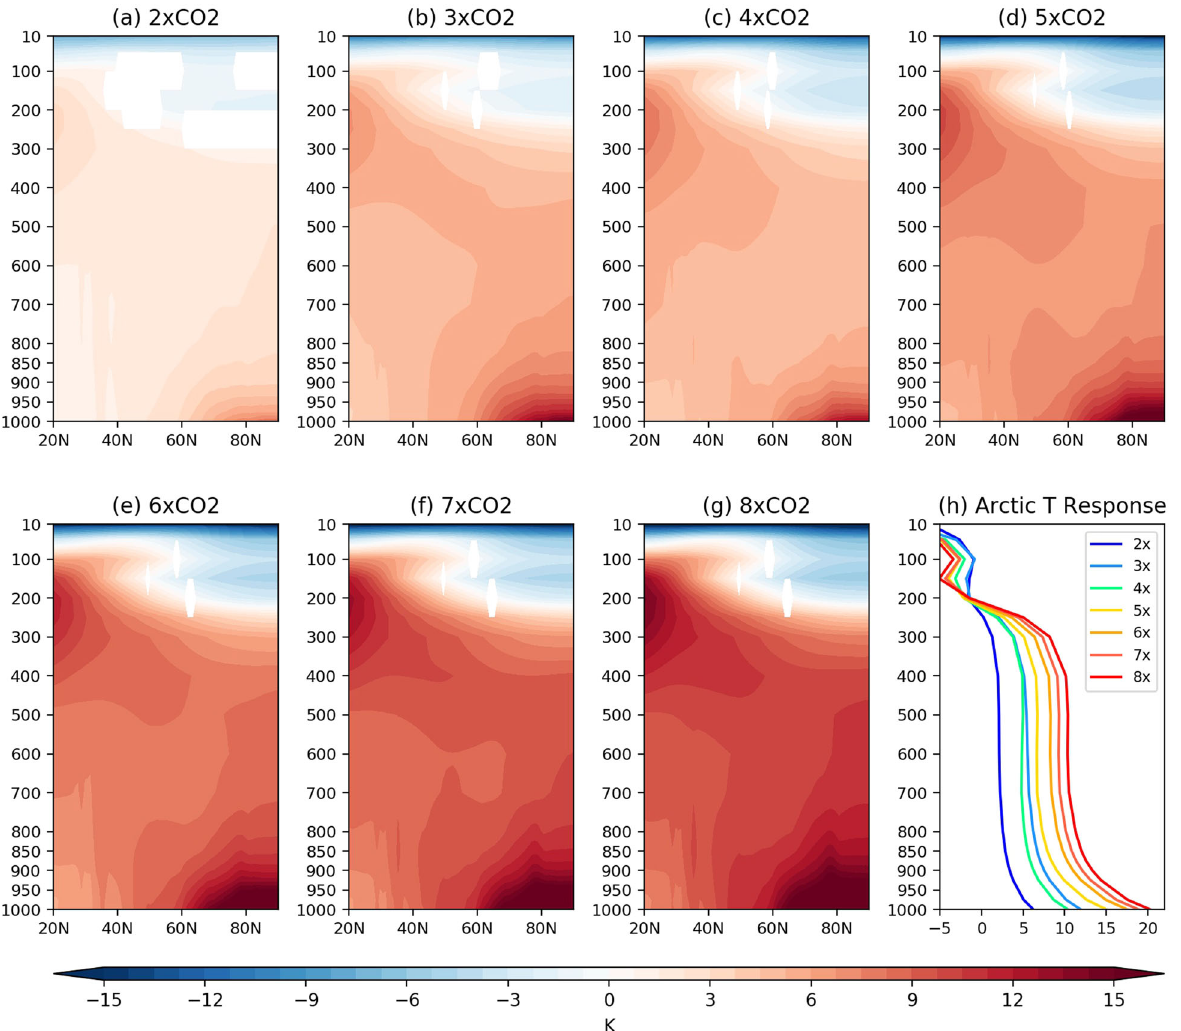
Fig. 2 Vertical structure of the zonal-mean air temperature response to increasing CO 2 forcing. a – g The zonal-mean air temperature responses for 2× to 8 × CO 2 respectively in fully coupled model experiments. Only the responses passing Student ’ s t -test with 95% con fi dence interval are shown. h Polar cap-averaged (60°N – 90°N) air temperature